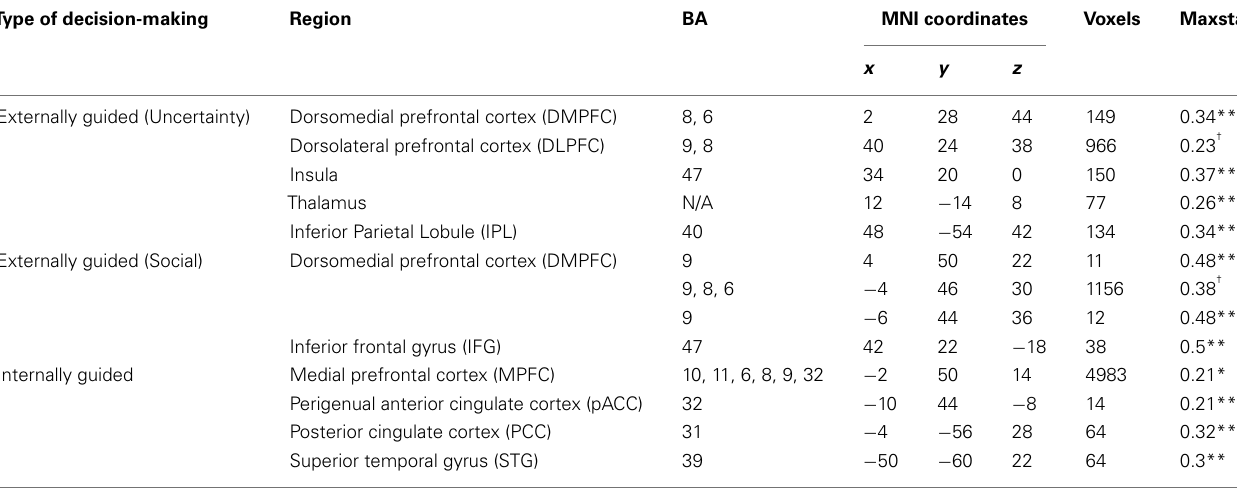
Table 2 | MKDA results for decision-making studies of each type. Type of decision-making